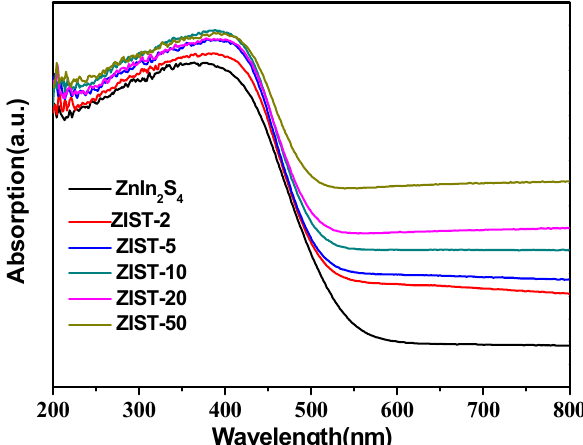
Figure 11. UV − vis DRS spectra of ZnIn 2 S 4 and ZnIn 2 S 4 /Ti 3 C 2 composites with different Ti 3 C 2 content.